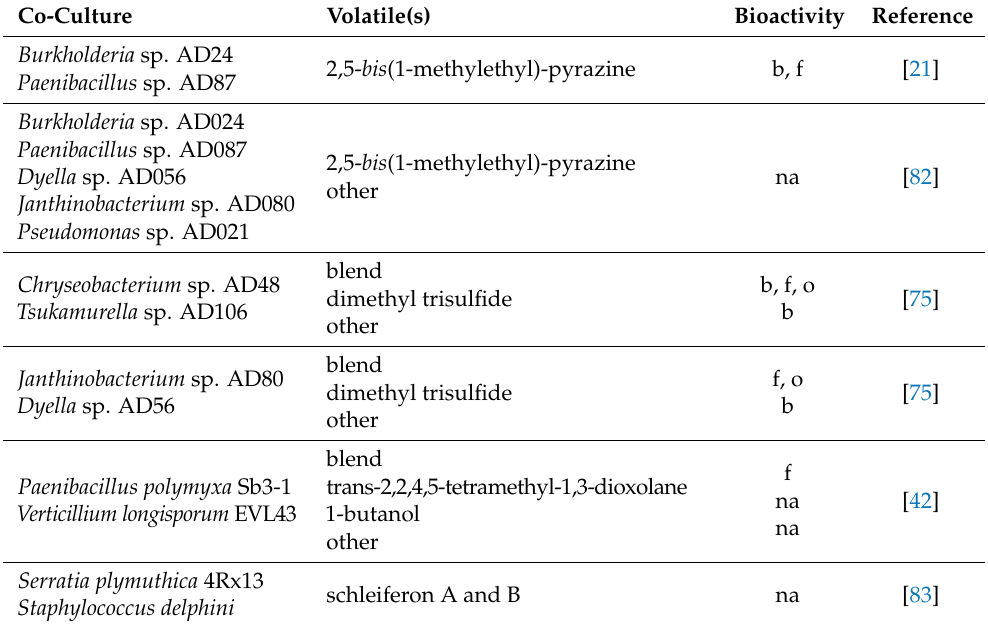
Table 2. Examples of bacterial volatiles that were upregulated or downregulated in co-cultures. blend = The volatile blend might be analyzed in the cited study but only the antimicrobial activity of the blend was tested. f = antifungal, b = antibacterial, o = anti-oomycete, na = not analyzed. Co-Culture Volatile(s) Bioactivity Reference Burkholderia sp. AD24 2,5- bis (1-methylethyl)-pyrazine b, f